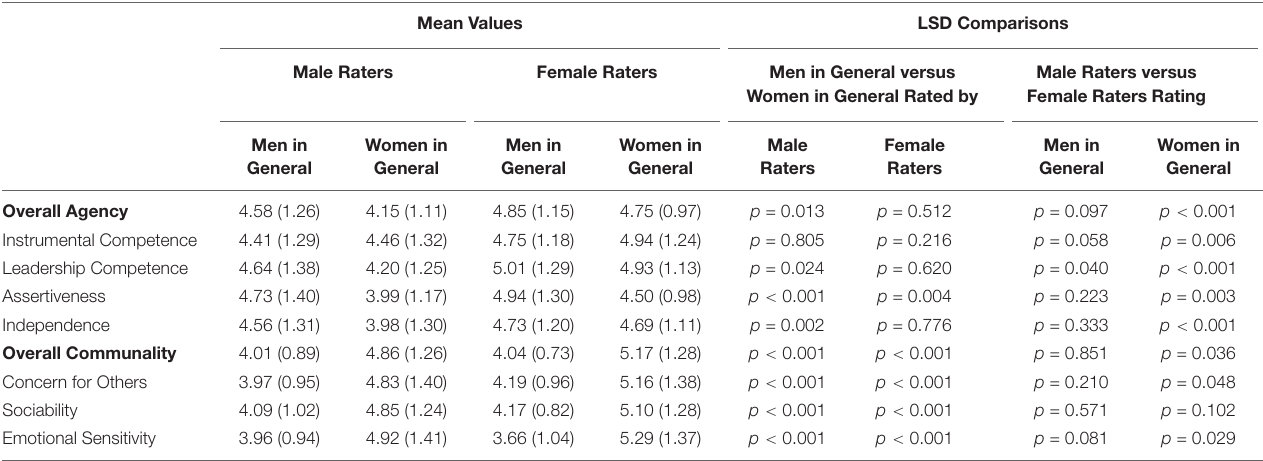
TABLE 4 | Means, standard deviations, and LSD results of stereotype